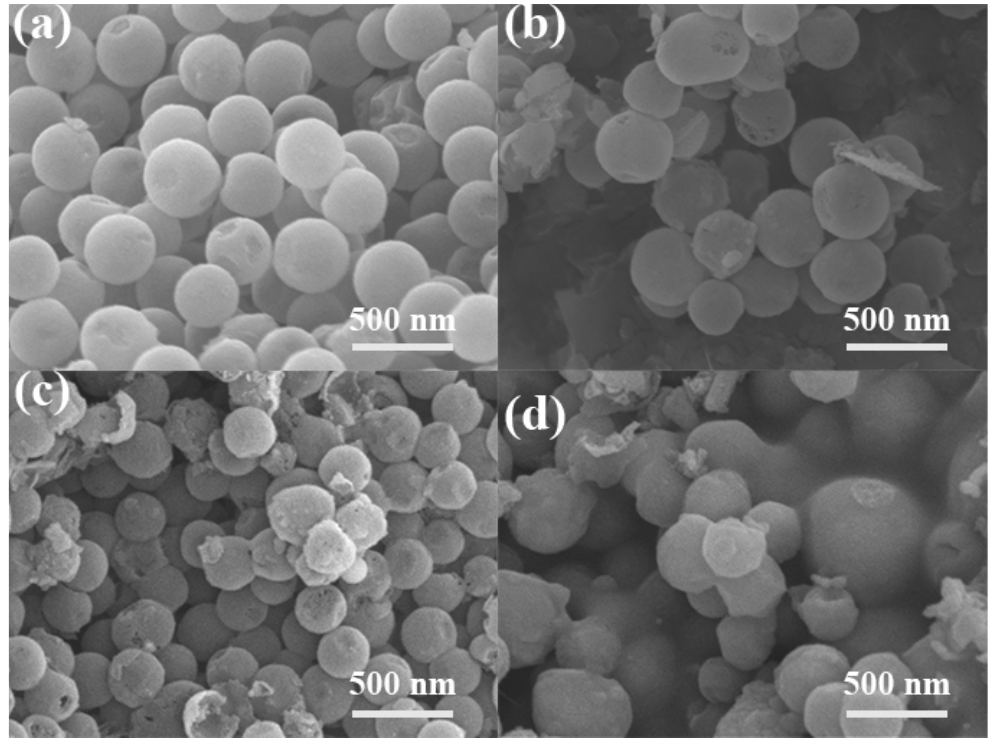
Figure 2. SEM images of ( a ) hollow N-doped carbon nanosphere (HNCS); ( b ) Fe@HNCS-800; ( c ) Fe@HNCS-900; and ( d ) Fe@HNCS-1000.